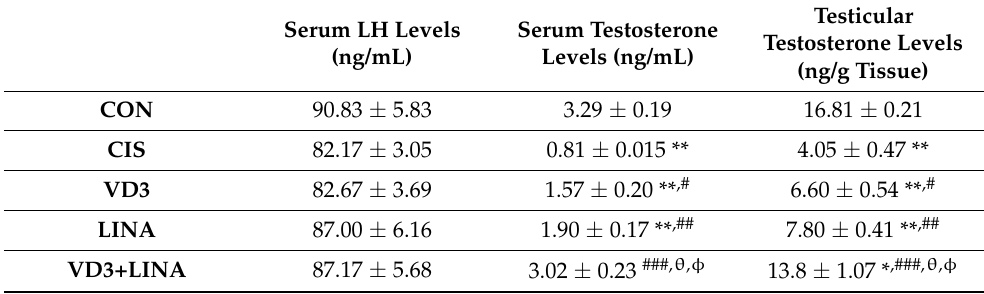
Table 4. Effect of vitamin D3 and/or linagliptin on gonadal hormone levels in cisplatin-treated